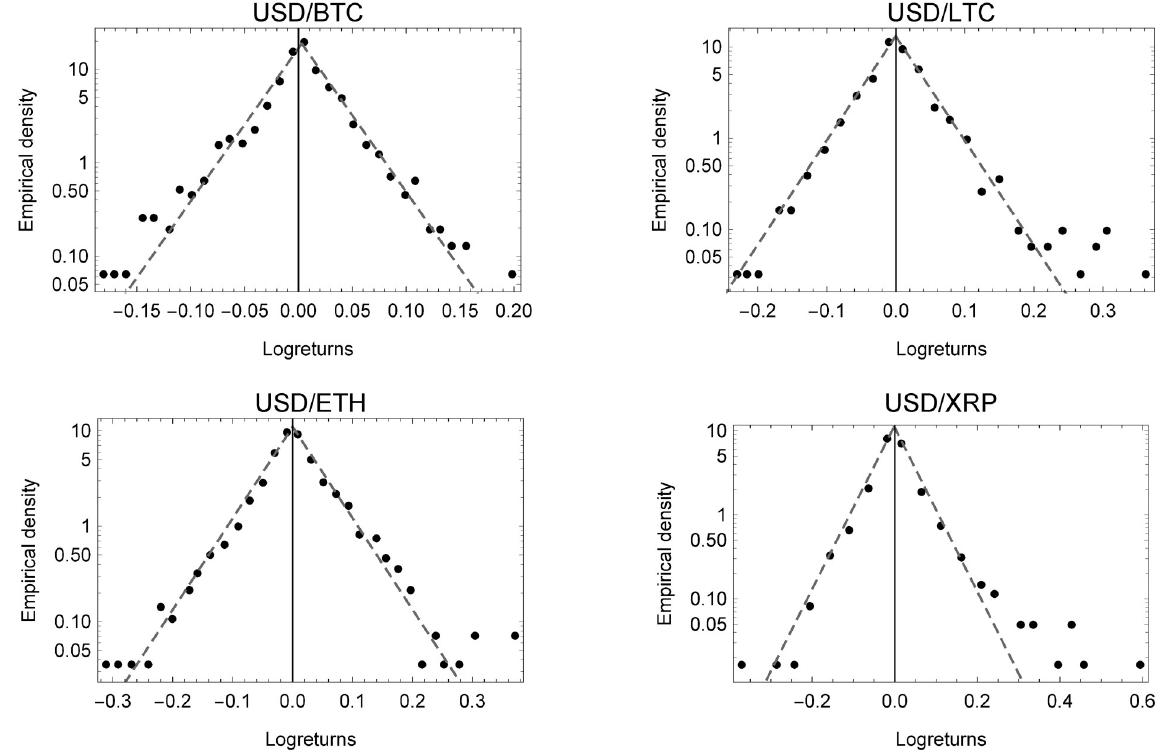
Fig 1. Empirical densities of virtual currencies. Empirical densities of currency exchange rate log-returns for the virtual currencies.